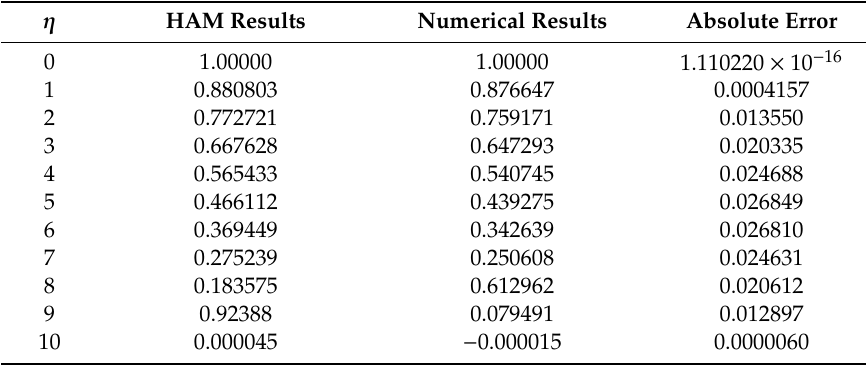
Table 5. Comparison results for column-shaped nanoparticles.